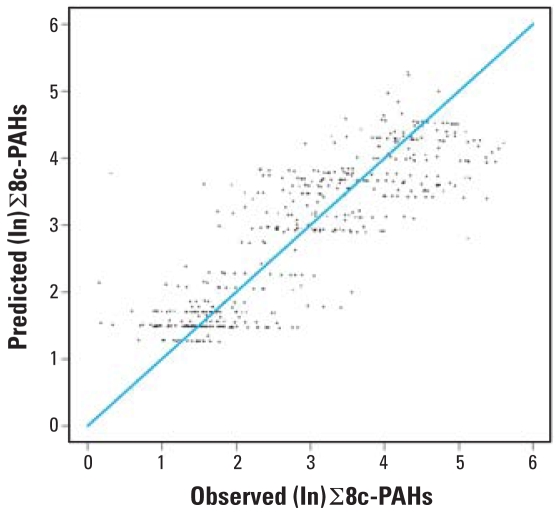
Predicted ∑8c-PAH exposure at sixth gestational month versus the observed ∑8c-PAH at same gestational period.